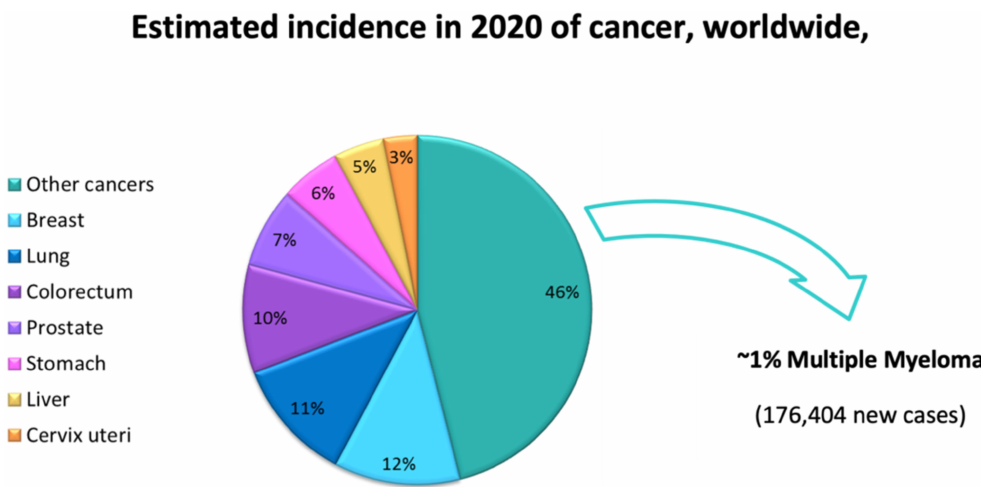
Figure 1. Estimated new cases of cancer in 2020, worldwide, both sexes and all ages. MM represents 1% of all types of cancer. Adapted from: Ferlay, J.; Ervik, M.; Lam, F.; Colombet, M.; Mery, L.; Piñeros, M.; Znaor, A.; Soerjomataram, I.; Bray, F. Global Cancer Observatory: Cancer Today; Lyon, France,